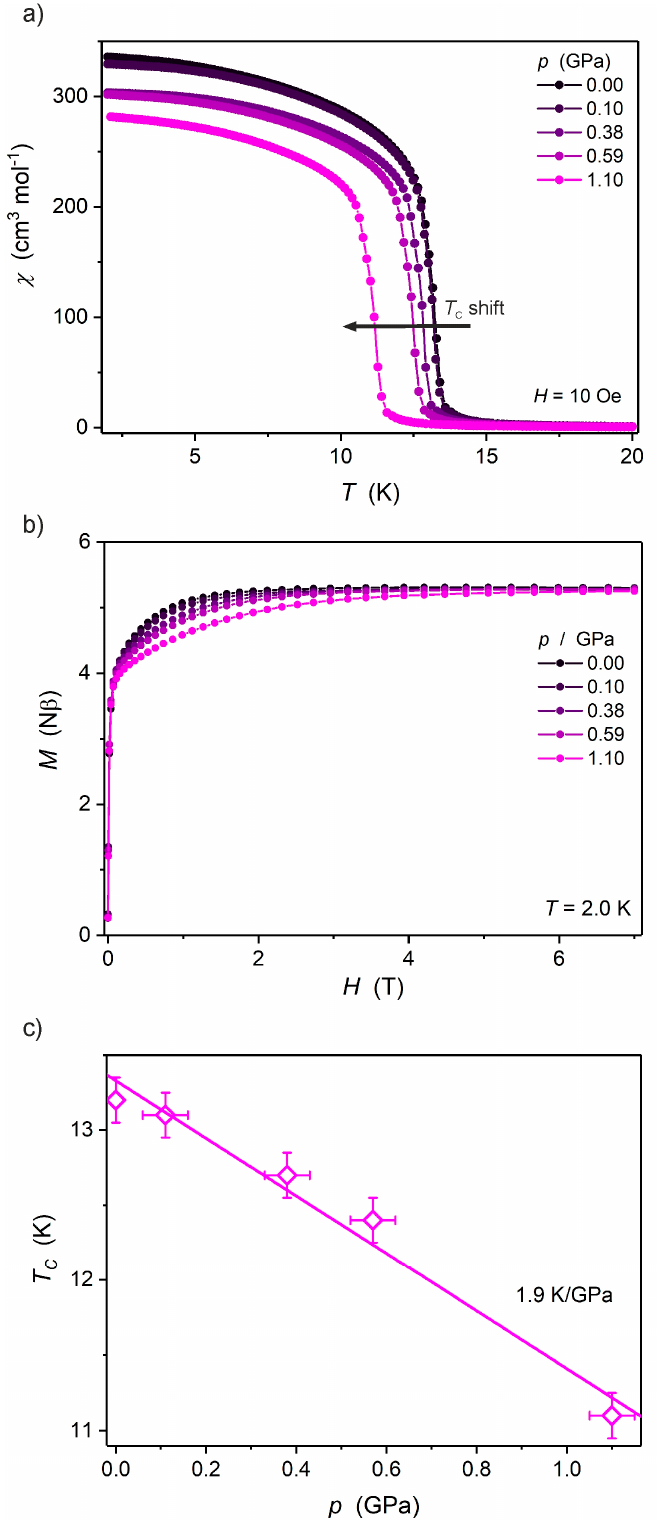
Figure 6. Temperature dependence of molar magnetic susceptibility χ ( T) at 10 Oe ( a ), M ( H ) at 2.0 K ( b ) and T c ( p ) ( c ) for Ni 2 Nb under high pressure. The solid lines in ( a , b ) are only guides for the eye, while in (c) it represents the best linear fit.